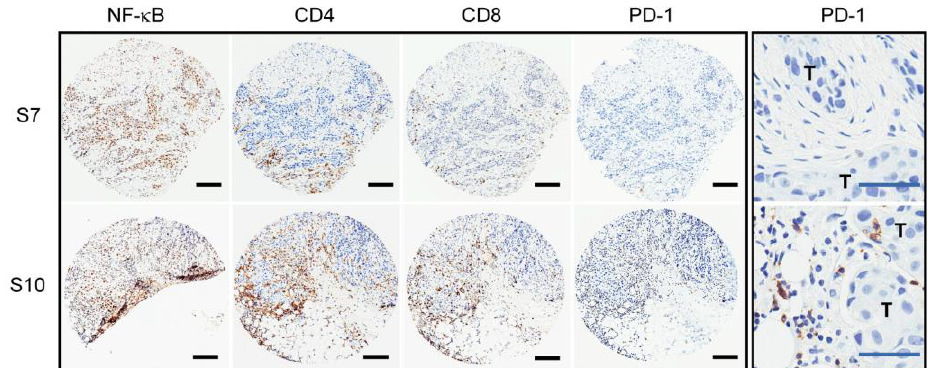
Figure 1. PD-1 positive immune environment in a subset of trastuzumab-treated HER2+ tumors. IHC staining images of tumors, S7 (PD-1 negative) and S10 (PD-1 positive) for NF- κ B, CD4, CD8, and PD-1; black scale bar denotes 200 μ m in length. The last panel contains higher magnification images of the PD-1 staining showing that PD-1-positive tumor immune cells in close proximity to tumor cells (large nuclei) in S10. T, tumor; blue scale bar denotes 50 μ m in length.